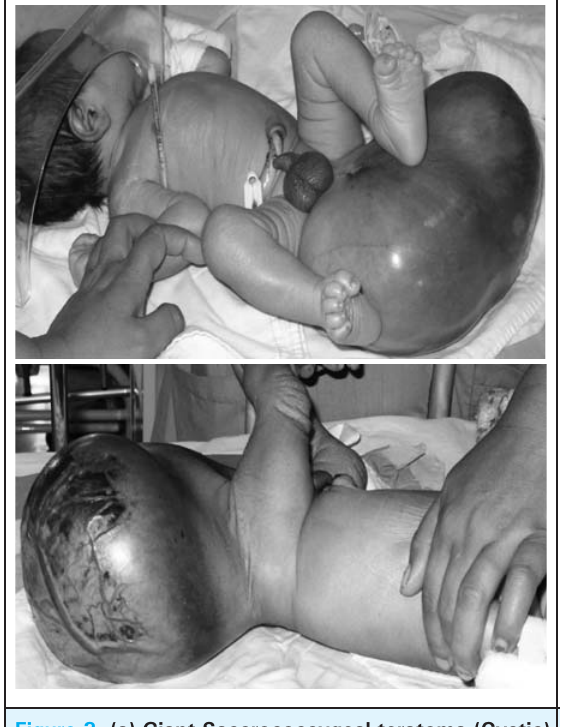
Figure 2. (a) Giant Saccrococcygeal teratoma (Cystic) (b) Lateral view of Saccrococcygeal